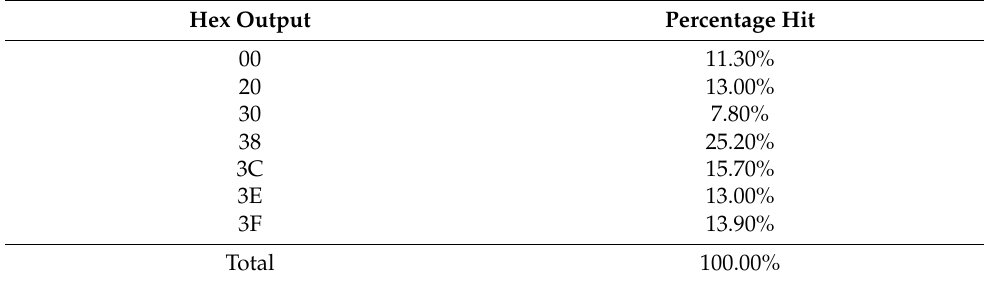
Table 5. Percentage of hex output hits for random delay signal